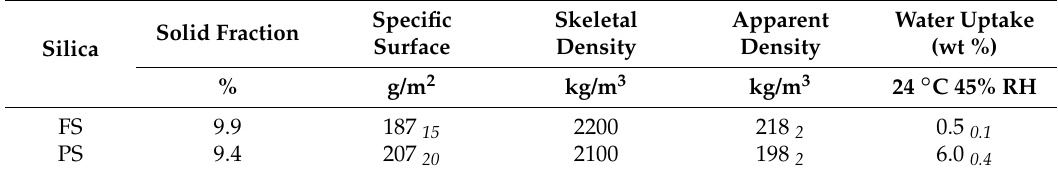
Table 1. Main physical characteristics of fumed silica (FS) and precipitated silica (PS) compacts (average values and standard deviations when available) as determined in this work. Water uptake is measured on silica powders; after drying at 140 ◦ C for 1 h, skeletal density is measured with a helium pycnometer (Accu-Pyc, Micrometritics, Norcross, GA, USA), and specific surface by nitrogen absorption (Belsorp-max, BEL, Germany). Numbers in italic stand for the standard